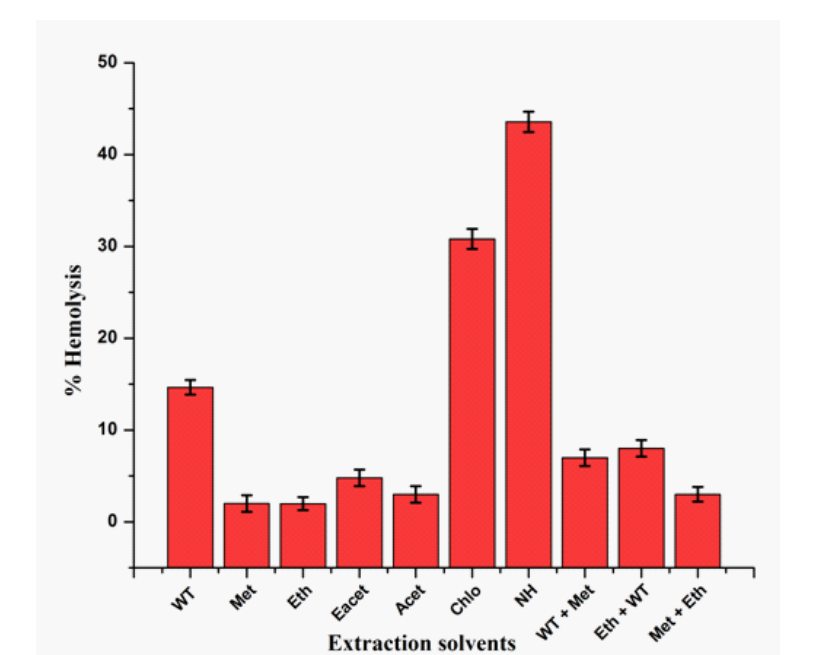
FIGURE 8 - Effect of different solvent extracts of E. intermedia on human erythrocytes. Data is represented as mean ± standard error of three separate experiments. WT: water, Met: methanol, Eth: ethanol, Eacet: ethyl acetate, Acet: acetone, Chlo: chloroform, NH: n-Hexane, Met + WT; methanol + water, Eth + WT; ethanol + water, Met + Eth; methanol + ethanol.